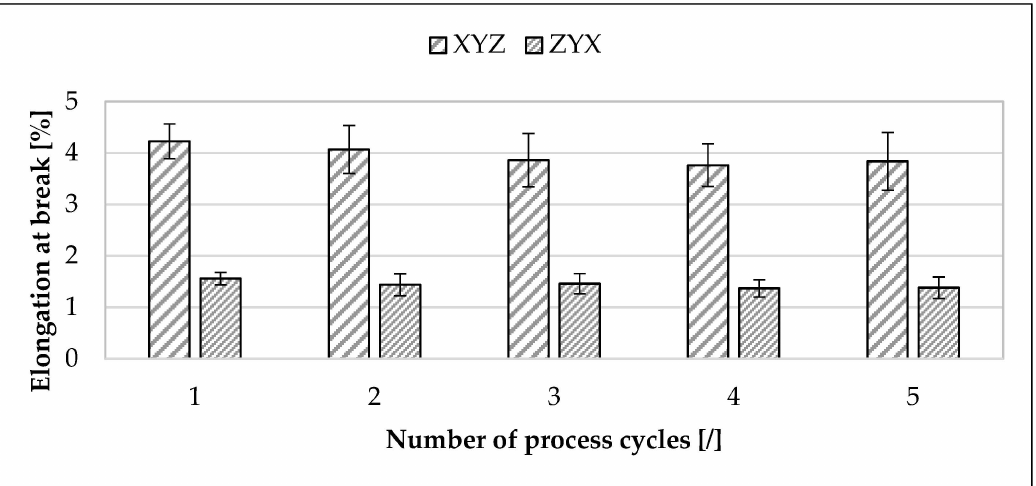
Figure 13. Influence of cyclic reuse on elongation at the break of the specimens manufactured from the used polyamide 12 sinter material. Five process cycles were considered. XYZ- and ZYX-specimens were analyzed. The refresh rate was 30